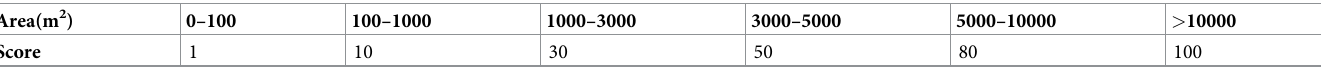
Table 3. The evaluation of different